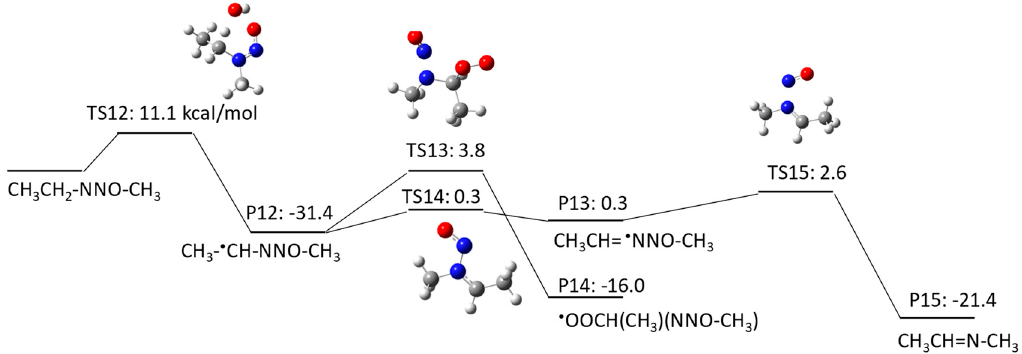
Figure 4. Free energy profile for pathway 2–1 of the HO • -induced reaction pathways for NMEA via H abstraction from a C–H bond of the –CH 2 – functional group adjacent to the N–NO functional group. The numbers (kcal/mol) are the free energy of activation for the TS and free energy of reaction for the P relative to the corresponding reactant.